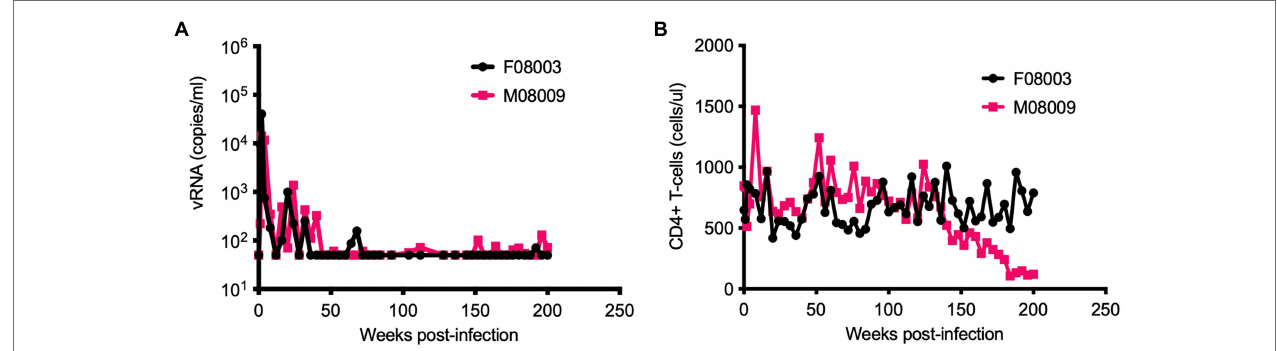
FIGURE 1 | Long-term monitoring of HSIV-vif NL4-3 infected pigtailed macaques (PTMs). Two juvenile PTMs (F08003 and M08009) were inoculated intravenously with HSIV-vif NL4-3 . Plasma viral RNA loads (A) and CD4 + T cell counts (B) were measured at various time points post-infection. Data up to 90 weeks post-infection (wpi) have been published previously (Thippeshappa et al., 2011). PTM M08009 shows gradual decline in CD4 + T cells at late-stage of